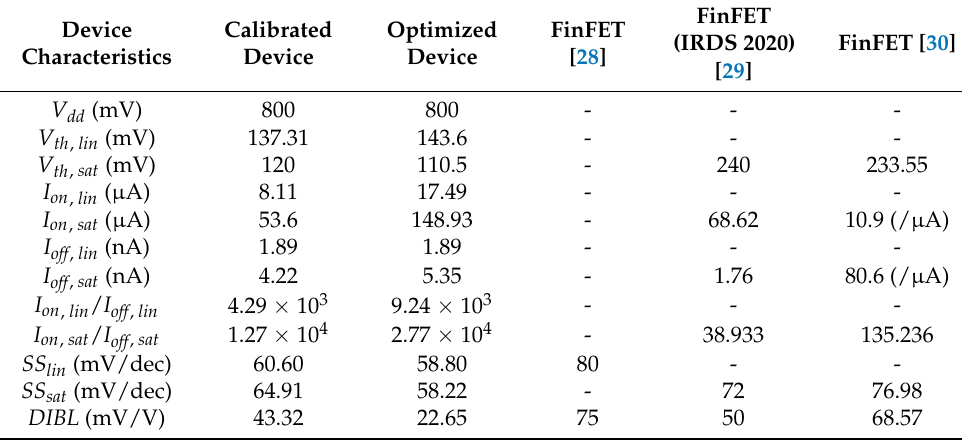
Table 3. Comparison of different 14-nm SOI n-FinFET device technologies.